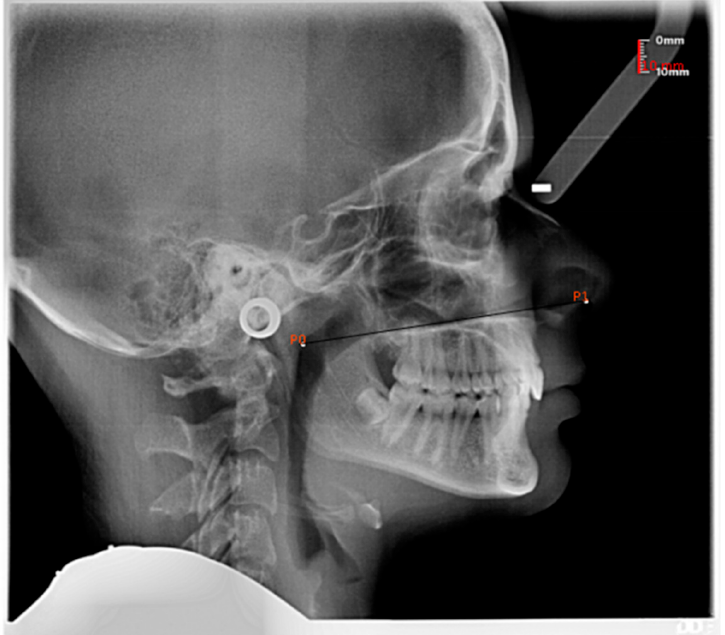
Figure 1. Measurement of the nostril to nasopharynx distance in a subject without adenoid hypertrophy. The measurement was recorded in mm from the most anterosuperior point of the nostril contour (P1) to the nasopharynx outline (P0), parallel to the palatal plane. In subjects exhibiting adenoid hypertrophy, the posterior landmark was taken on the anterior outline of adenoid tissue [21,22] (Figure 2).